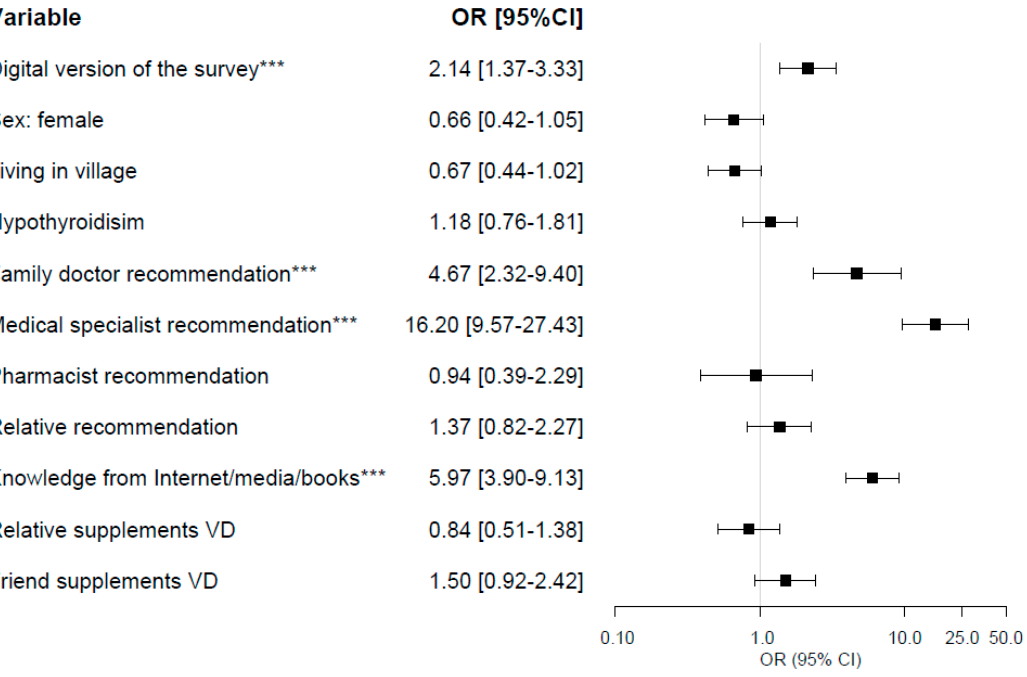
Figure 1. Multivariate logistic regression model. Dependent variable: declaration of vitamin D supplementation; *** p < 0.001. CI—confidence interval, OR—odds ratio, VD—Vitamin D